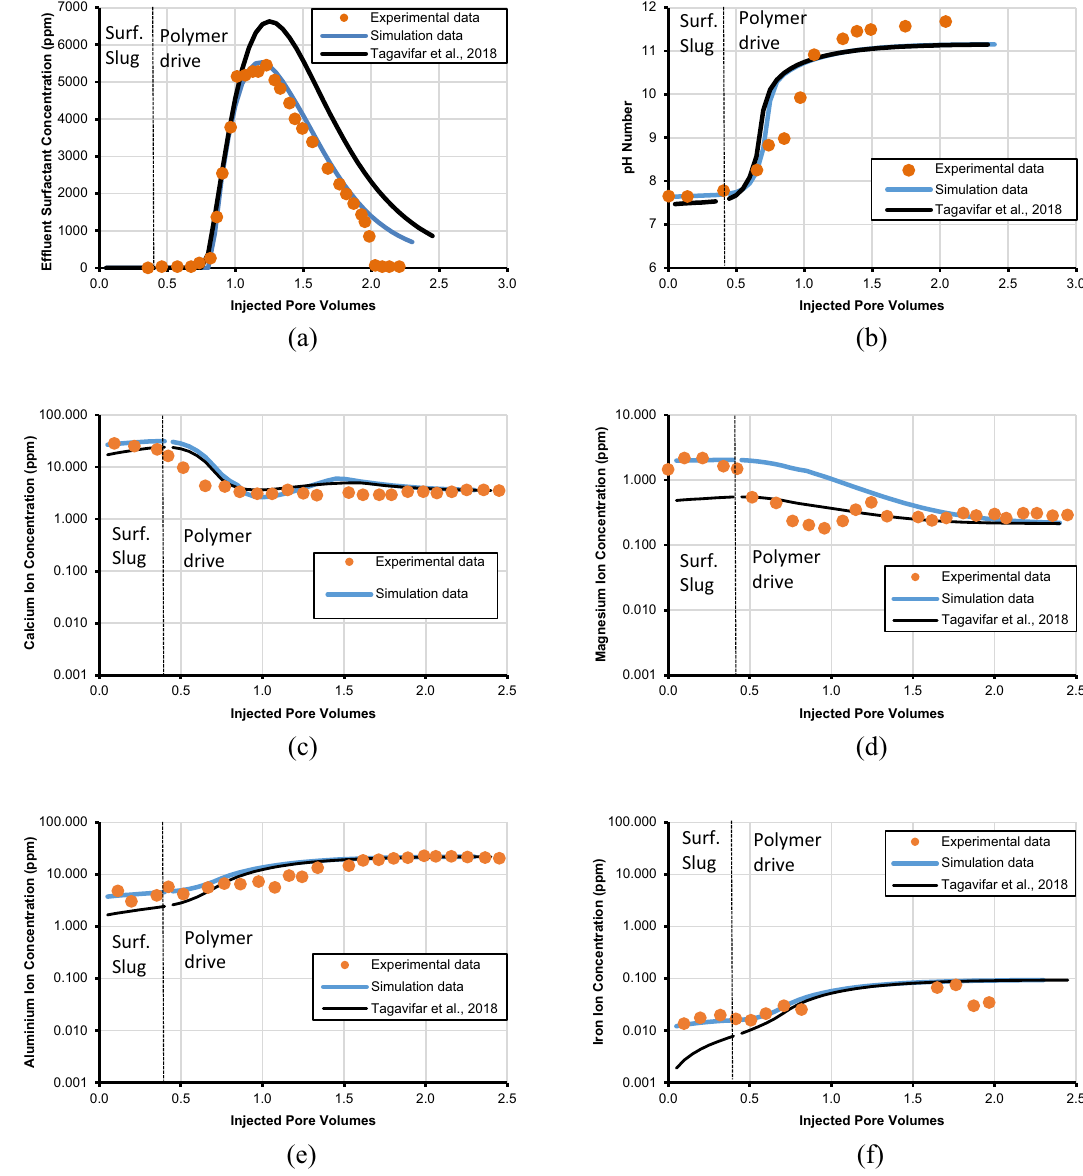
Figure 2. Comparison of the developed model with the experimental and simulation data of Tagavifar et al. 18 ; ( a ) effluent surfactant concentration, ( b ) pH, ( c ) calcium concentration, ( d ) magnesium concentration, ( e ) aluminum concentration, ( f ) iron concentration. Salinity unit Ions Ca 2+ Na + Cl − SO 42- Mg 2+ Al 3+ Fe 2+ Total Salinity Synthetic brine composition (Tagavifar et al. 18